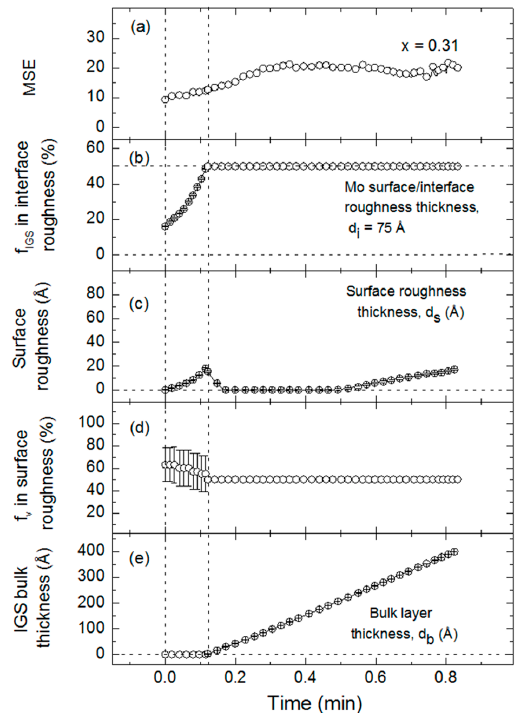
Figure 13. Best fit structural parameters and resulting mean square error (MSE) that characterize the first ~400 Å of (In 1 − x Ga x ) 2 Se 3 ( x = 0.31) bulk layer growth on a Mo-coated, thermally-oxidized Si wafer